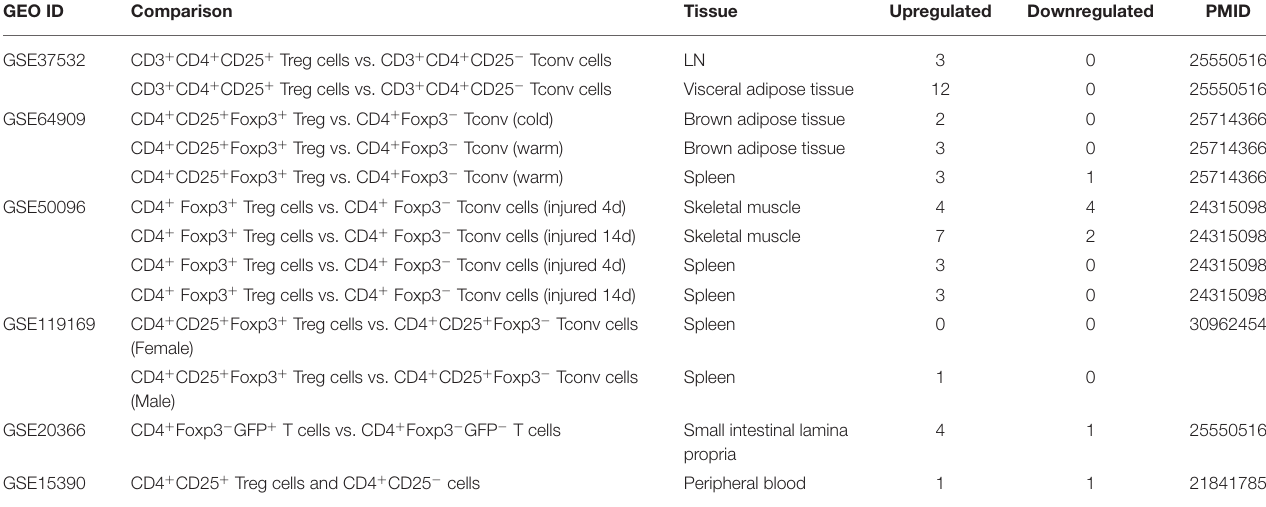
TABLE 5 | Six microarray datasets about Treg cells in the National Institutes of Health (NIH)–National Center for Biotechnology Information (NCBI)–Gene Expression Omnibus (GEO) datasets database (https://www.ncbi.nlm.nih.gov/gds/) were collected to analyze the changes of organelle interactions and vesicle-related gene ( p < 0.05, |logFC| >